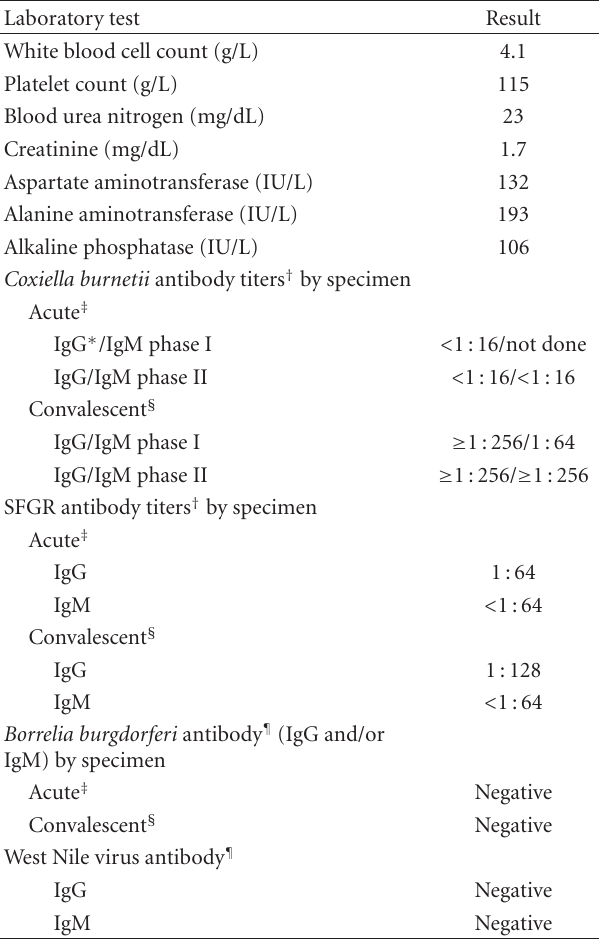
Table 1: Case-patient laboratory test results, Montana, 2011. Laboratory